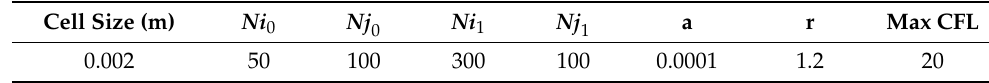
Table 3. Grid information.